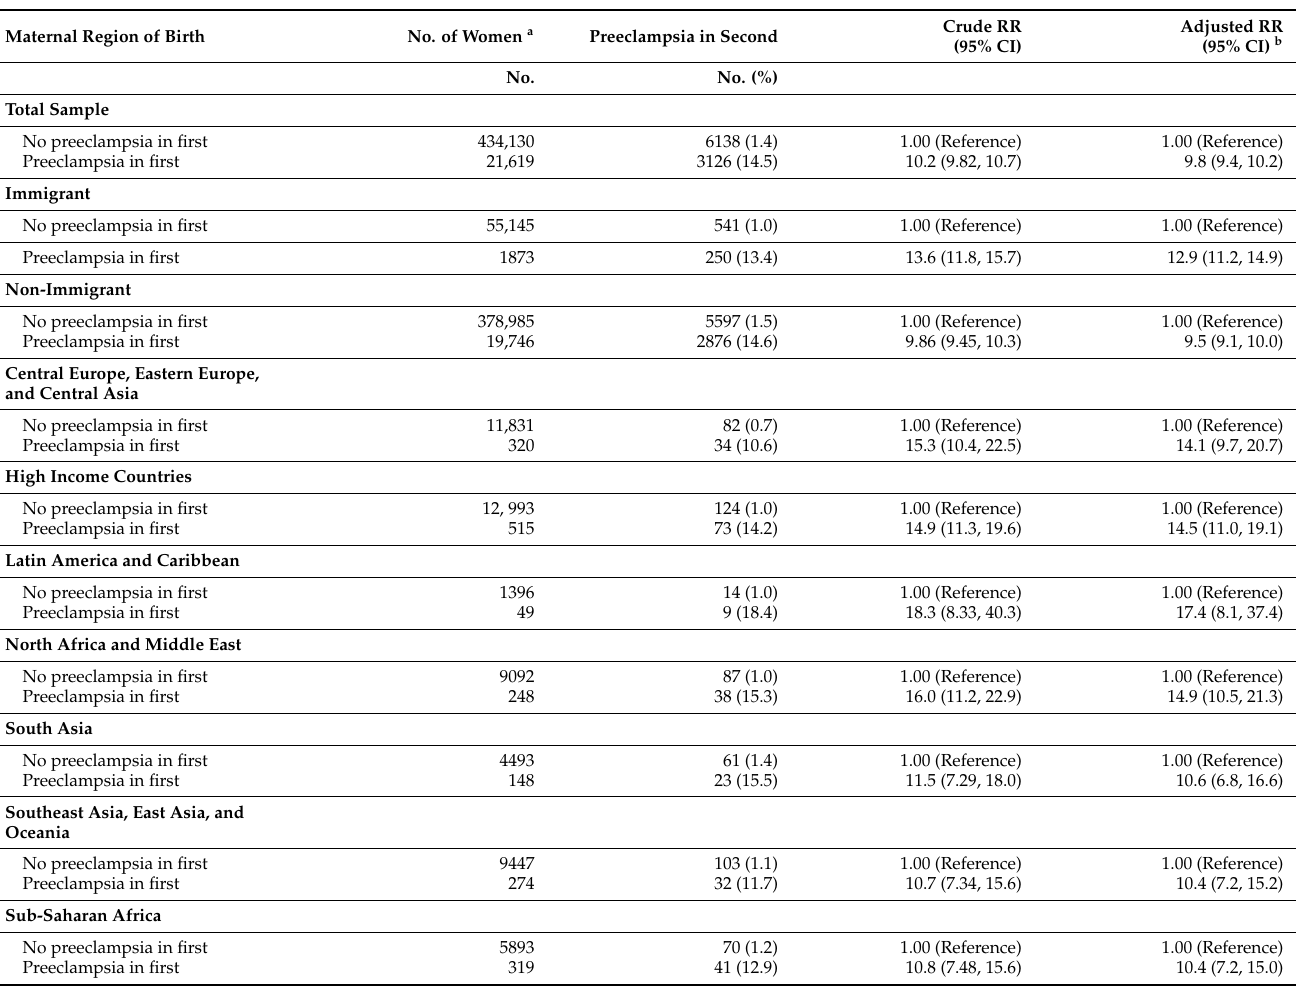
Table 2. Risk ratios (RRs) with 95% confidence intervals (CIs) for preeclampsia in second pregnancy by maternal region of birth, Norway,